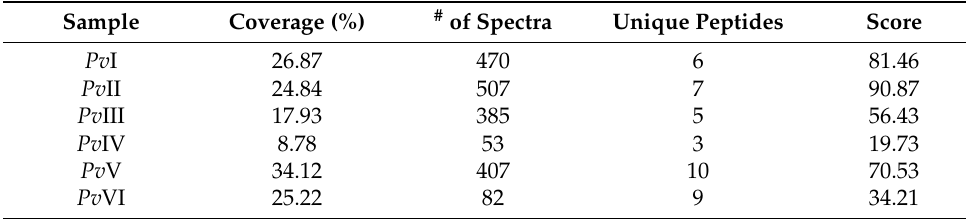
Table 3. The identified proteins compared against the local database of P. vulgaris .